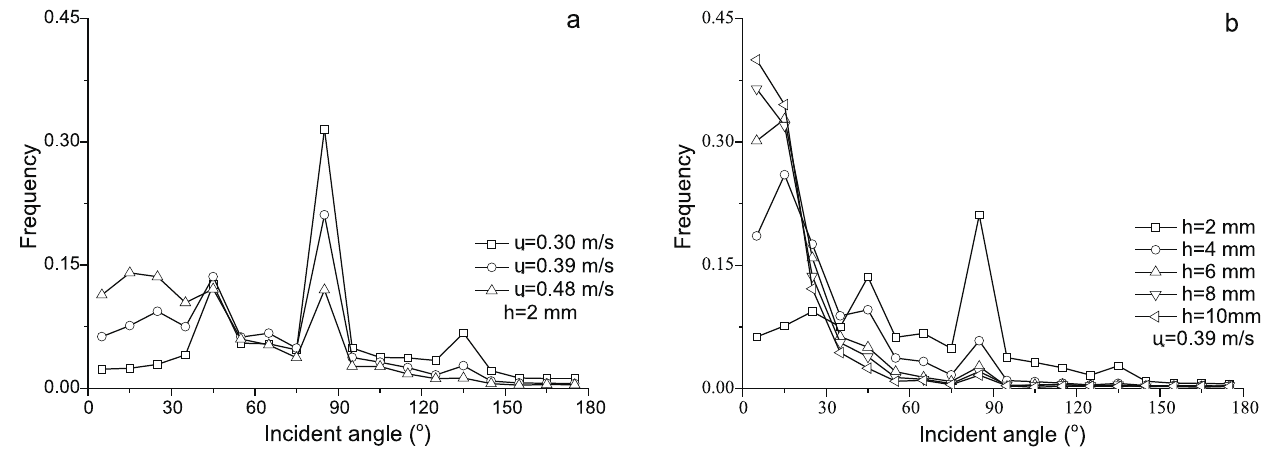
Figure 4. The population distributions of incident angles in different wind strengths (a) and measuring height (b).